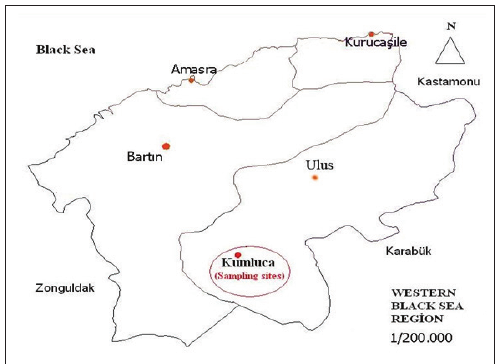
FIGURE 1. The locations of sampling sites at Kumluca-Bartin in